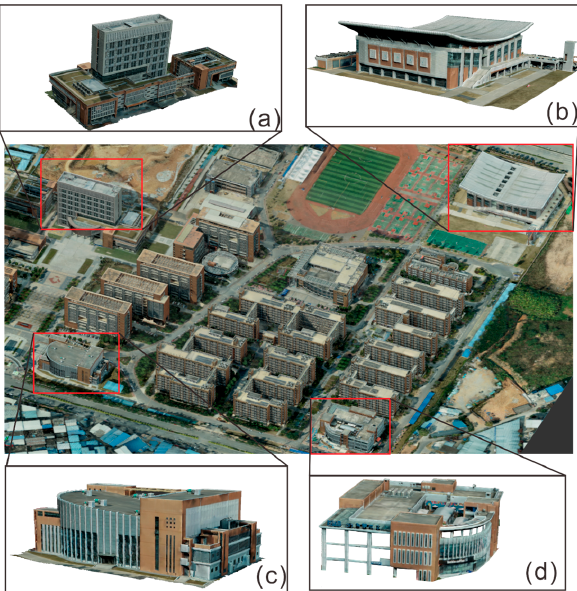
Figure 20. Merging DTM- and DBM-based T 2 Oms on dataset 2; ( a – d ) are an enlarged windows of the four